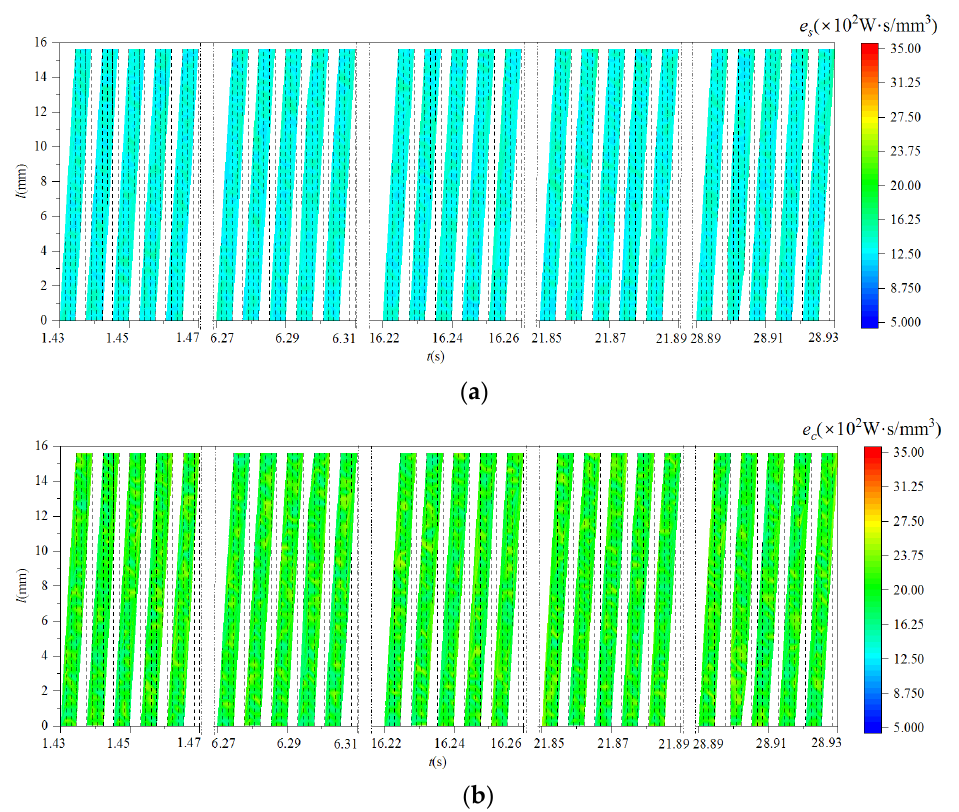
Figure 21. The distribution of specific cutting energy of cutter teeth (scheme 2). ( a ) The distribution of specific shear energy of cutter teeth; ( b ) the distribution of specific tangential-force energy of cutter tooth.